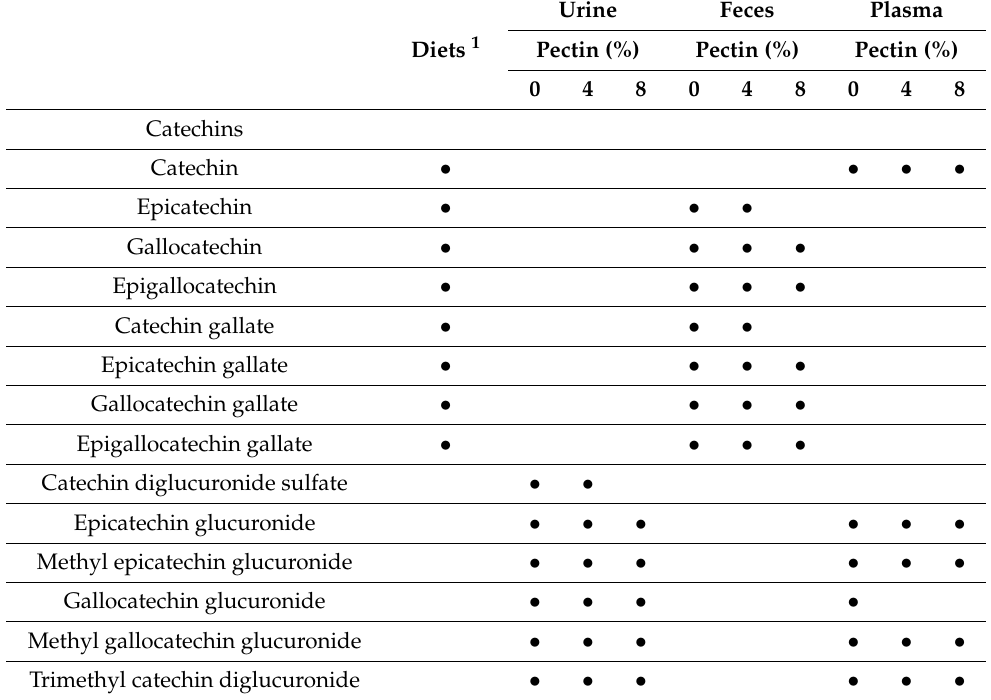
Table 4. Polyphenols identified in diets, and urine, feces and plasma of rats fed experimental